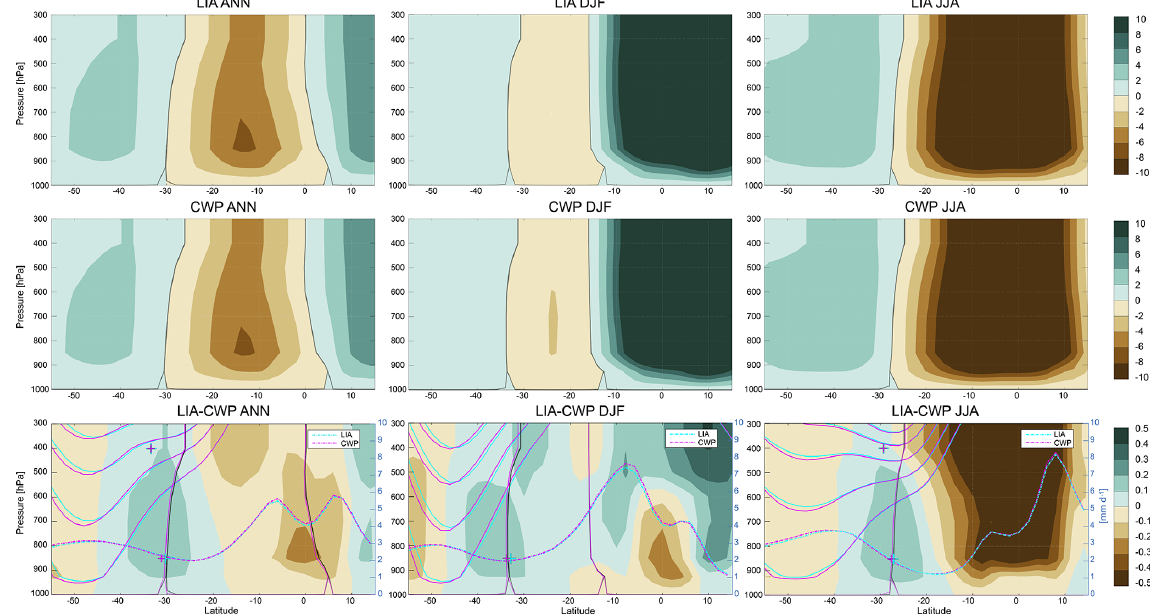
Figure 5. Mass stream function ensemble mean during the LIA, CWP, and LIA–CWP (shades) for the annual mean (ANN), austral summer (DJF), and austral winter (JJA). The zonal mean precipitation (dash-dotted lines), zonal mean winds (solid lines), subtropical ridge position (lower crosses), and latitude of maximum zonal winds at 200hPa (upper crosses) during the LIA (cyan) and the CWP (magenta) are also